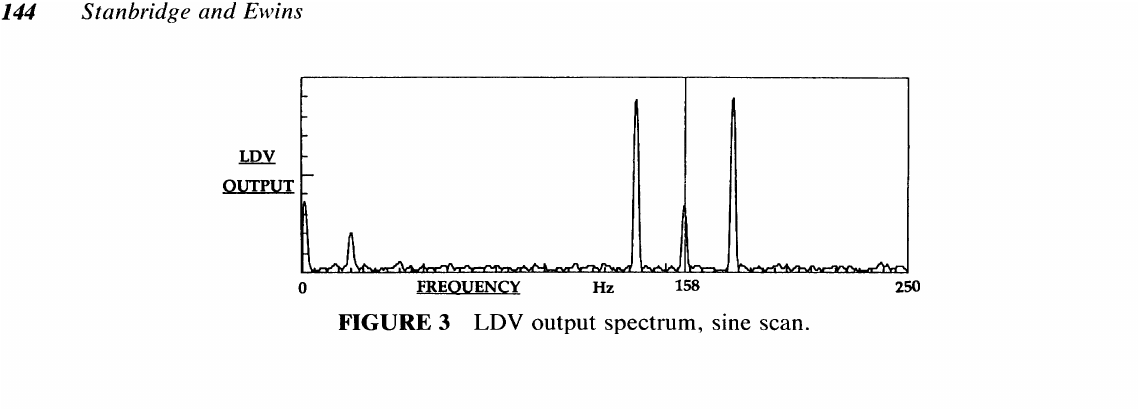
FIGURE 3 LDV output spectrum, sine scan.